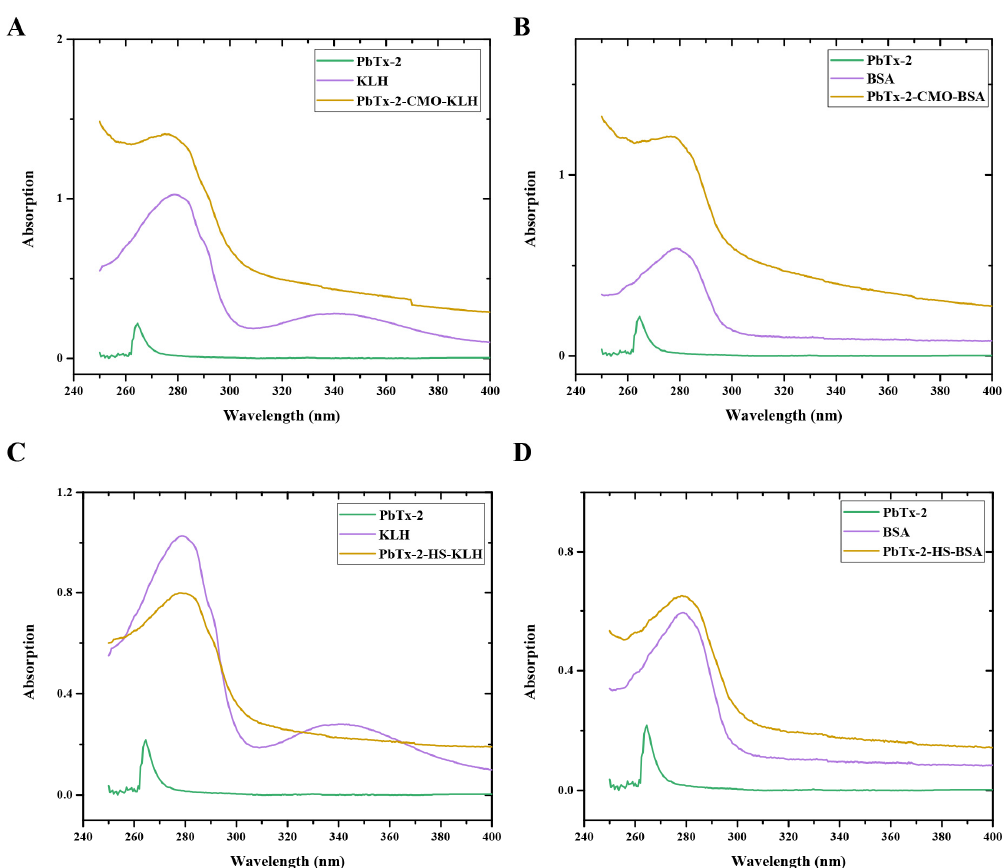
Figure 4. UV–visible absorption spectra of PbTx-2-CMO-KLH ( A ), PbTx-2-CMO-BSA ( B ), PbTx-2-CMO-KLH ( C ) and PbTx-2-CMO-BSA ( D ).